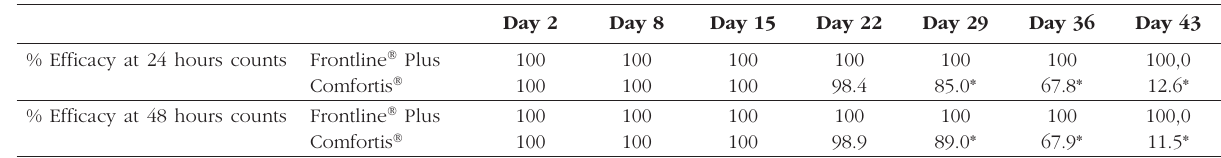
Table II. – Number of fleas counted at 24 hours and 48 hours post-infestation, from Day 21 infestation to Day 42 infestation. Calculation of the % of flea free dogs and comparison between the two treated groups.